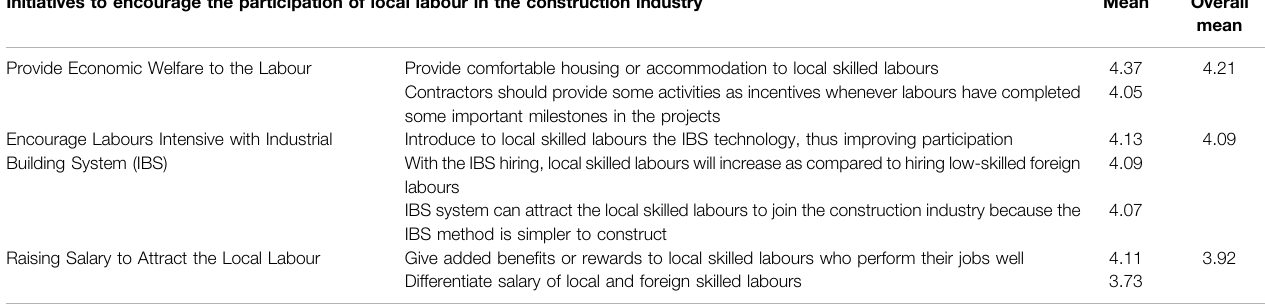
TABLE 8 | Initiatives to encourage the participation of local labour in the construction